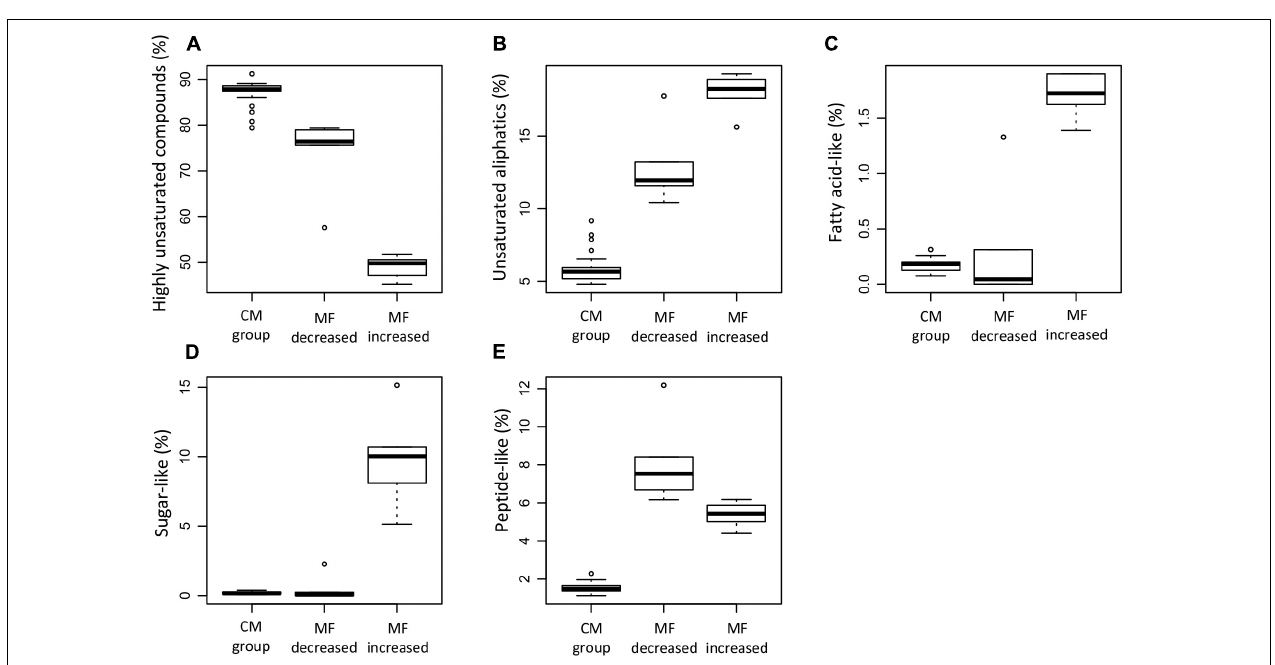
FIGURE 10 | Box plots summarizing and comparing (A) the modified aromaticity index (AI mod ) and (B) the double bond equivalent (DBE) of the molecular formulae that significantly decreased (MF dec., n = 315), the molecular formulae that significantly increased (MF inc., n = 254), and the molecular formulae in the conservative mixing group (CM group, n = 13,462). The information corresponds to the averages weighted by FT-ICR-MS signal intensity for each of the samples.